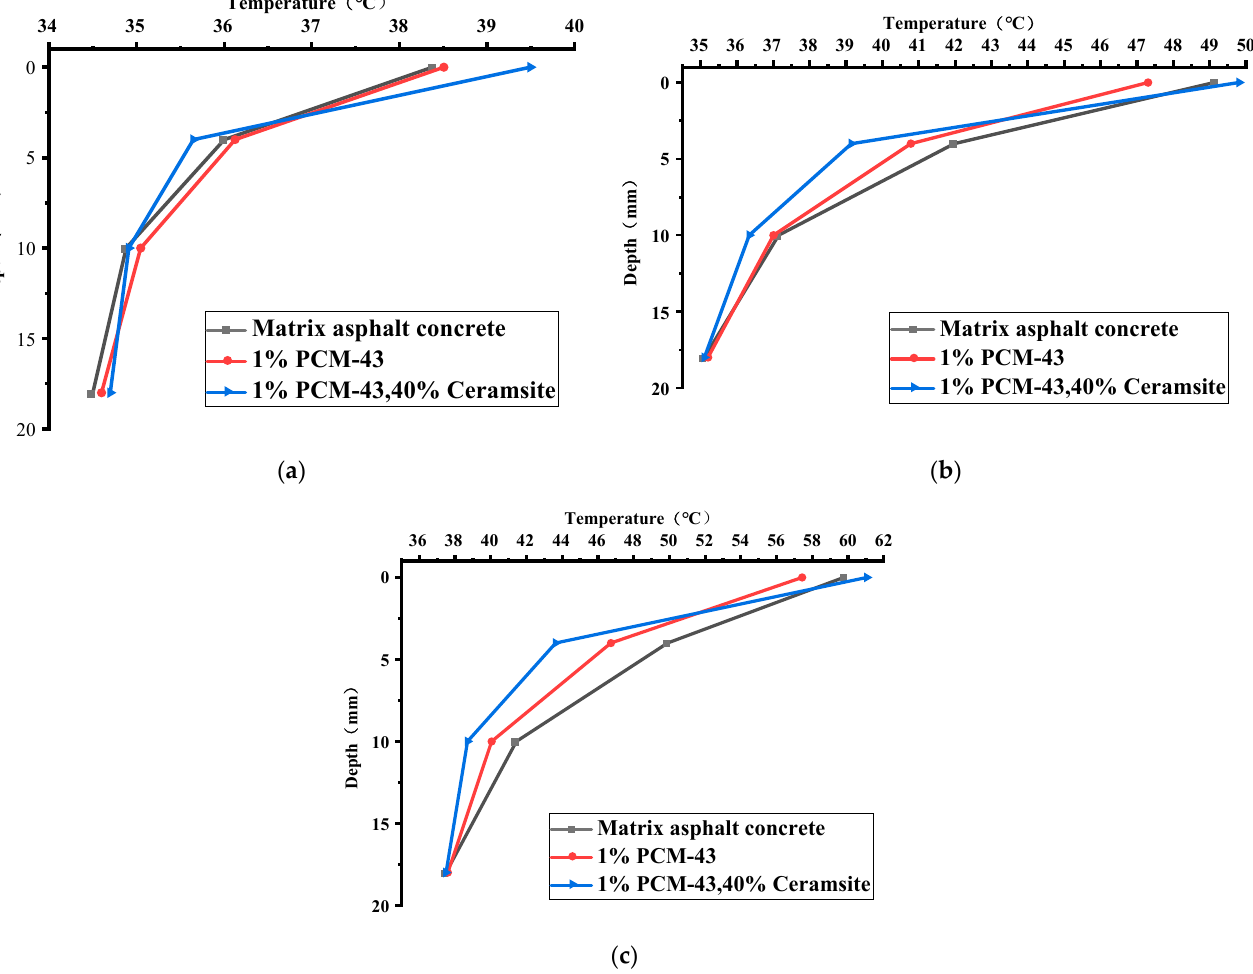
Figure 10. Temperature of pavement structure changing with depth: ( a ) 10:00; ( b ) 12:00; ( c ) 14:00.